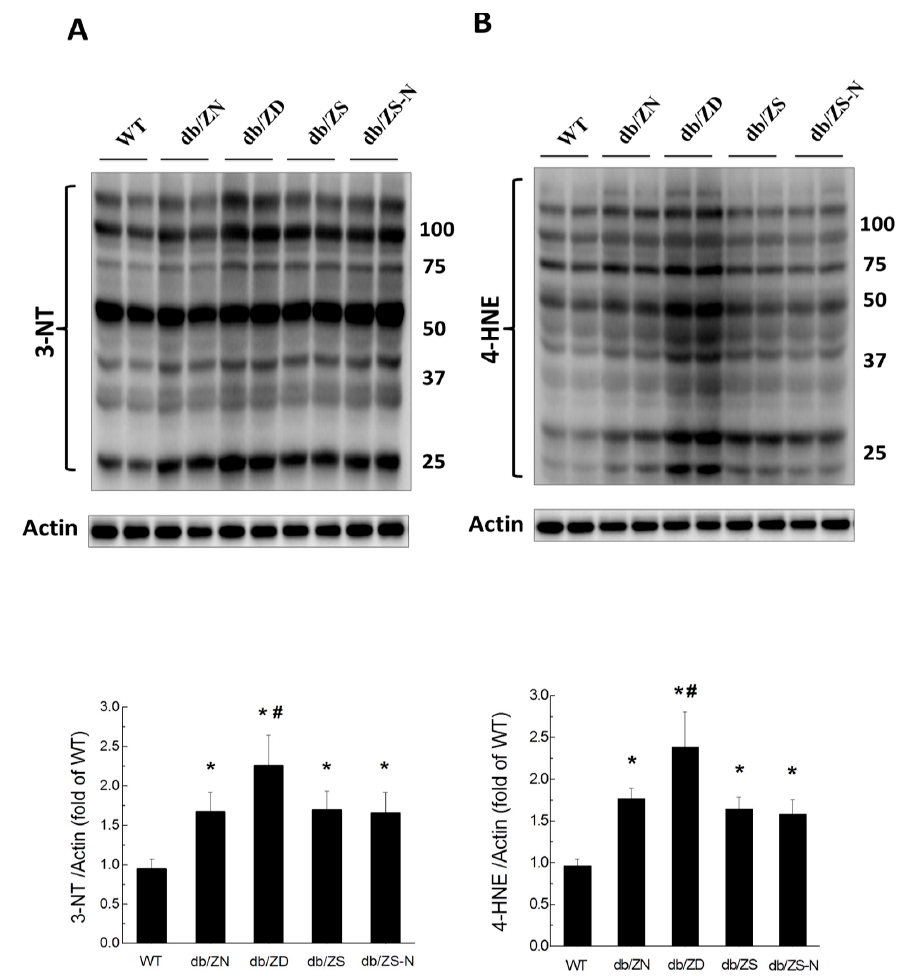
Figure 5. Zn exacerbates diabetes ‐ induced cardiac oxidative damage. Oxidative damage was examined by Western blot for 3 ‐ NT ( A ) and 4 ‐ HNE ( B ) accumulation in the myocardium, followed by quantitative analysis. 3 ‐ NT includes all nitrated tyrosine containing proteins ( A ). Similarly, 4 ‐ HNE includes all proteins containing 4 ‐ hydroxy ‐ 2 ‐ nonenal (a peroxide lipid) ( B ). All bands were quantified. Data were presented as mean ± SD ( n = 4–7, details in Figure 1). *, p < 0.05 vs. WT group; #, p < 0.05 vs. db/ZN group.